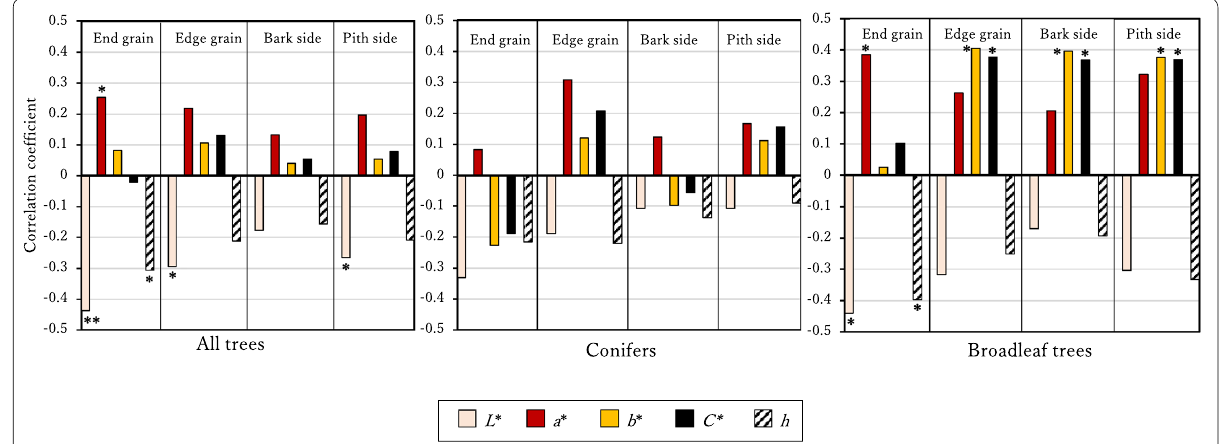
Fig. 7 Correlations between density and L *, a *, b *, C *, h of each measured plane. Significance level * p < 0.05, ** p <